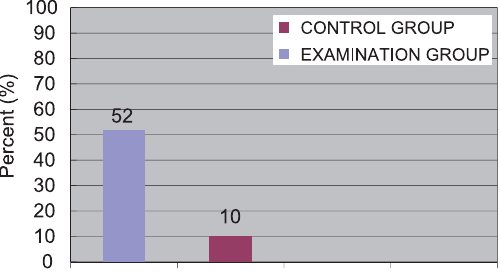
FIGURE 2. Level of physical activity of women without estro-